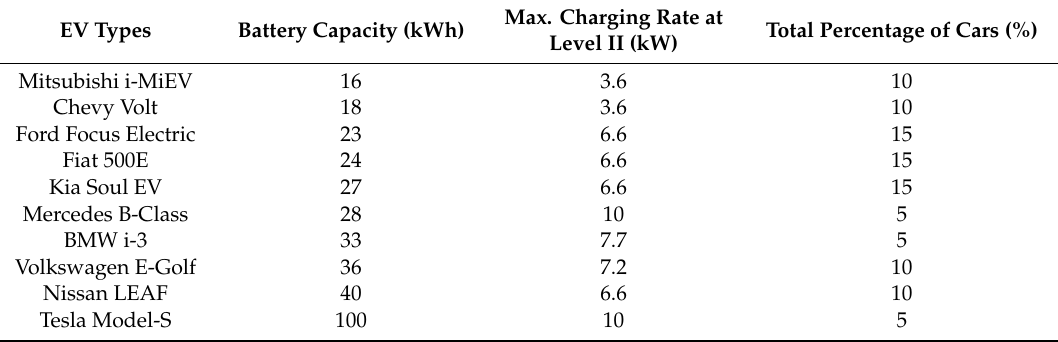
Table 2. Battery Capacity, Charge Rate and Division of Electric